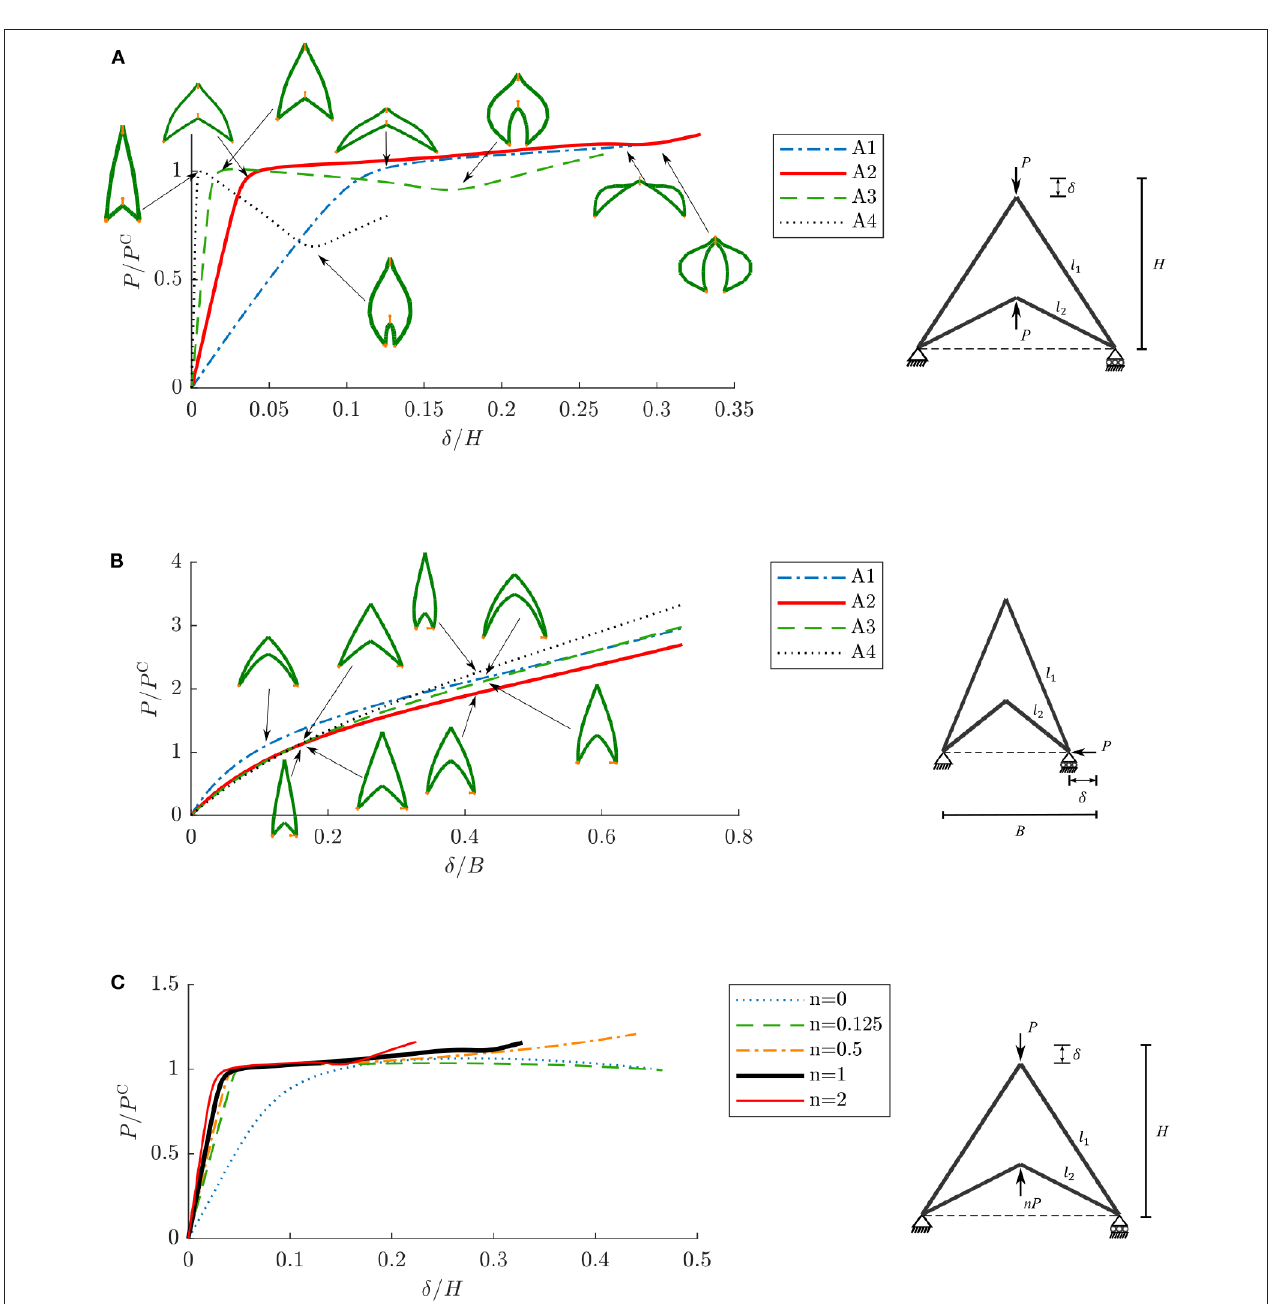
FIGURE 8 | Normalized load vs. normalized axial end-shortening responses for unit cell models. (A) P / P C vs. δ/ H for arrowhead cells with varying inclination angles under vertical compression loading. (B) P / P C vs. δ/ B for arrowhead cells with varying inclination angles under horizontal compression loading. (C) P / P C vs. δ/ H for the arrowhead cell A2 with inclination angles θ